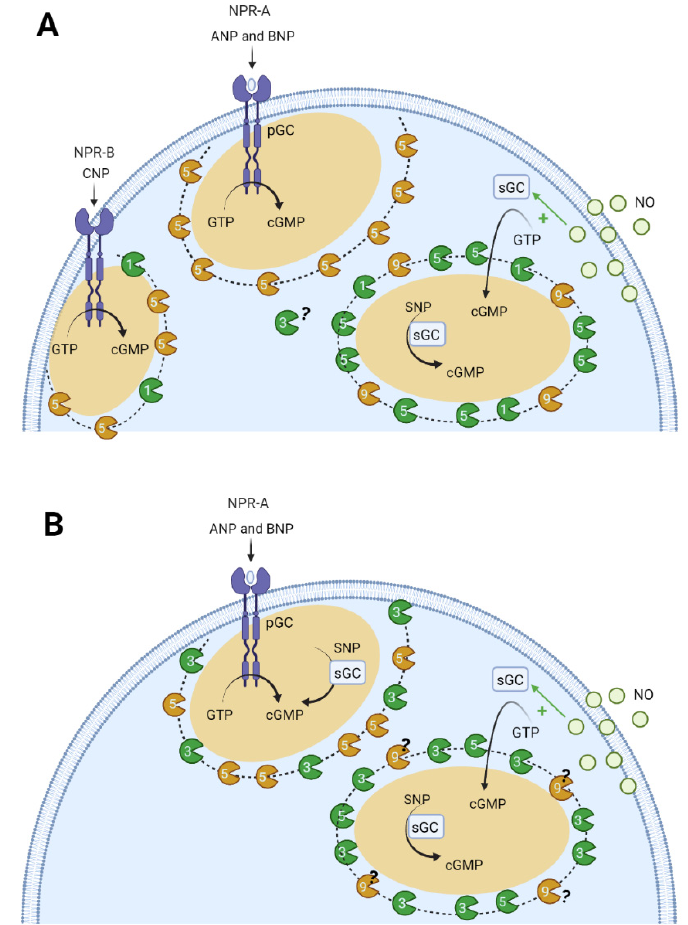
Figure 6. Schematic representation of compartmentation of cGMP signalling in vascular SMCs in ( A ) a synthetic and ( B ) a contractile phenotype (created with biorender.com). In synthetic phenotype ( A ), activating natriuretic peptide receptors A and B leads to a pool of pGC/cGMP mainly controlled by PDE5. Moreover, activation of soluble guanylyl cyclases (sGC) by NO leads to a generation of cGMP in the intracellular medium also mainly controlled by PDE5. In the contractile phenotype ( B ), activating natriuretic peptide receptors A leads to a pool of pGC/cGMP controlled by PDE5 and PDE3. Activation of soluble guanylyl cyclases (sGC) by NO leads to generation of cGMP in the intracellular medium mainly controlled by PDE3.